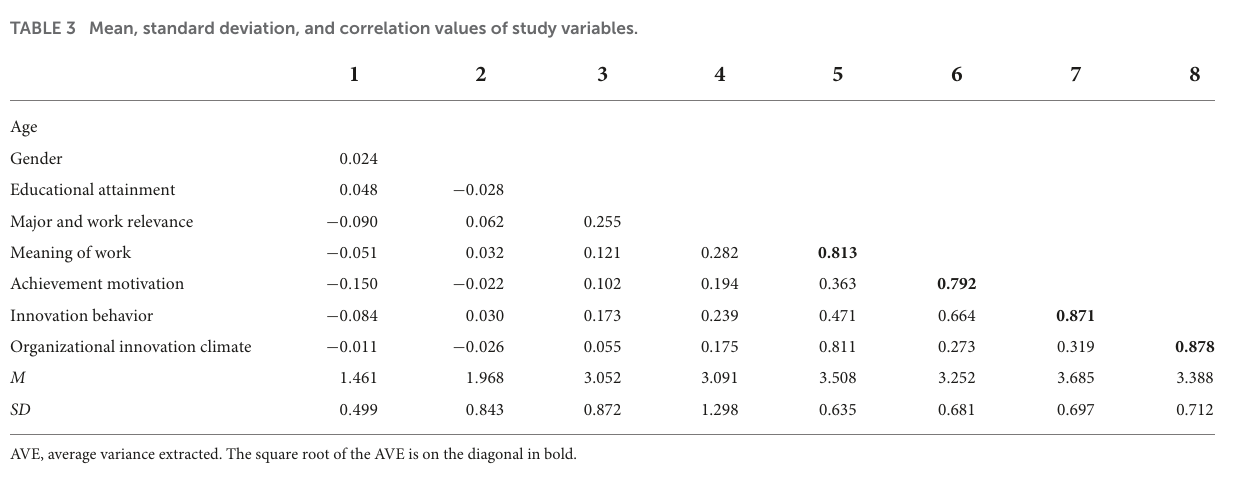
TABLE 4 Standardized regression weights for direct and indirect paths with hypotheses results.